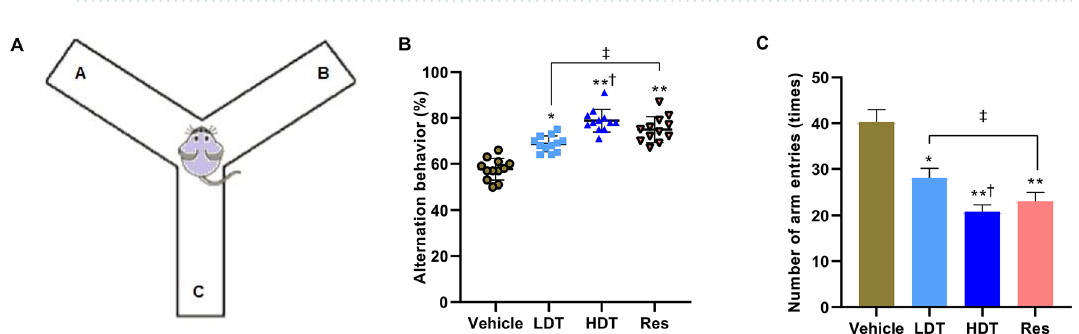
Figure 1. Barnes circular maze task for spatial memory test of 4-month-old 5xFAD mice after 45 consecutive days (P30-75) treatment with W. somnifera . Representative heat maps ( A ), and data that compare the latency time ( B ) and the average number of error head pokes ( C ) to enter the escape box during the acquisition training phase. ( D ) The probe trial time-spent in the target zone to locate the hole which previously contained the escape box. The data represent the mean ± SEM. Data were from 12 different mice in each group (n = 12) using repeated-measures ANOVA (in B , C ), two-way ANOVA, one-way ANOVA, Tukey’s multiple comparisons tests. Significance is indicated by * p < 0.05; ** p < 0.01; *** p < 0.001 versus vehicle; by † p < 0.05, †† p < 0.01 between W. somnifera treated groups; by ‡ p < 0.05, ‡‡ p < 0.01 between W. somnifera and Res treated groups; by ^ p < 0.05 between days 1 and 5 (in C ). Vehicle control group, LDT low dose treatment, HDT high dose treatment, Res Resveratrol.